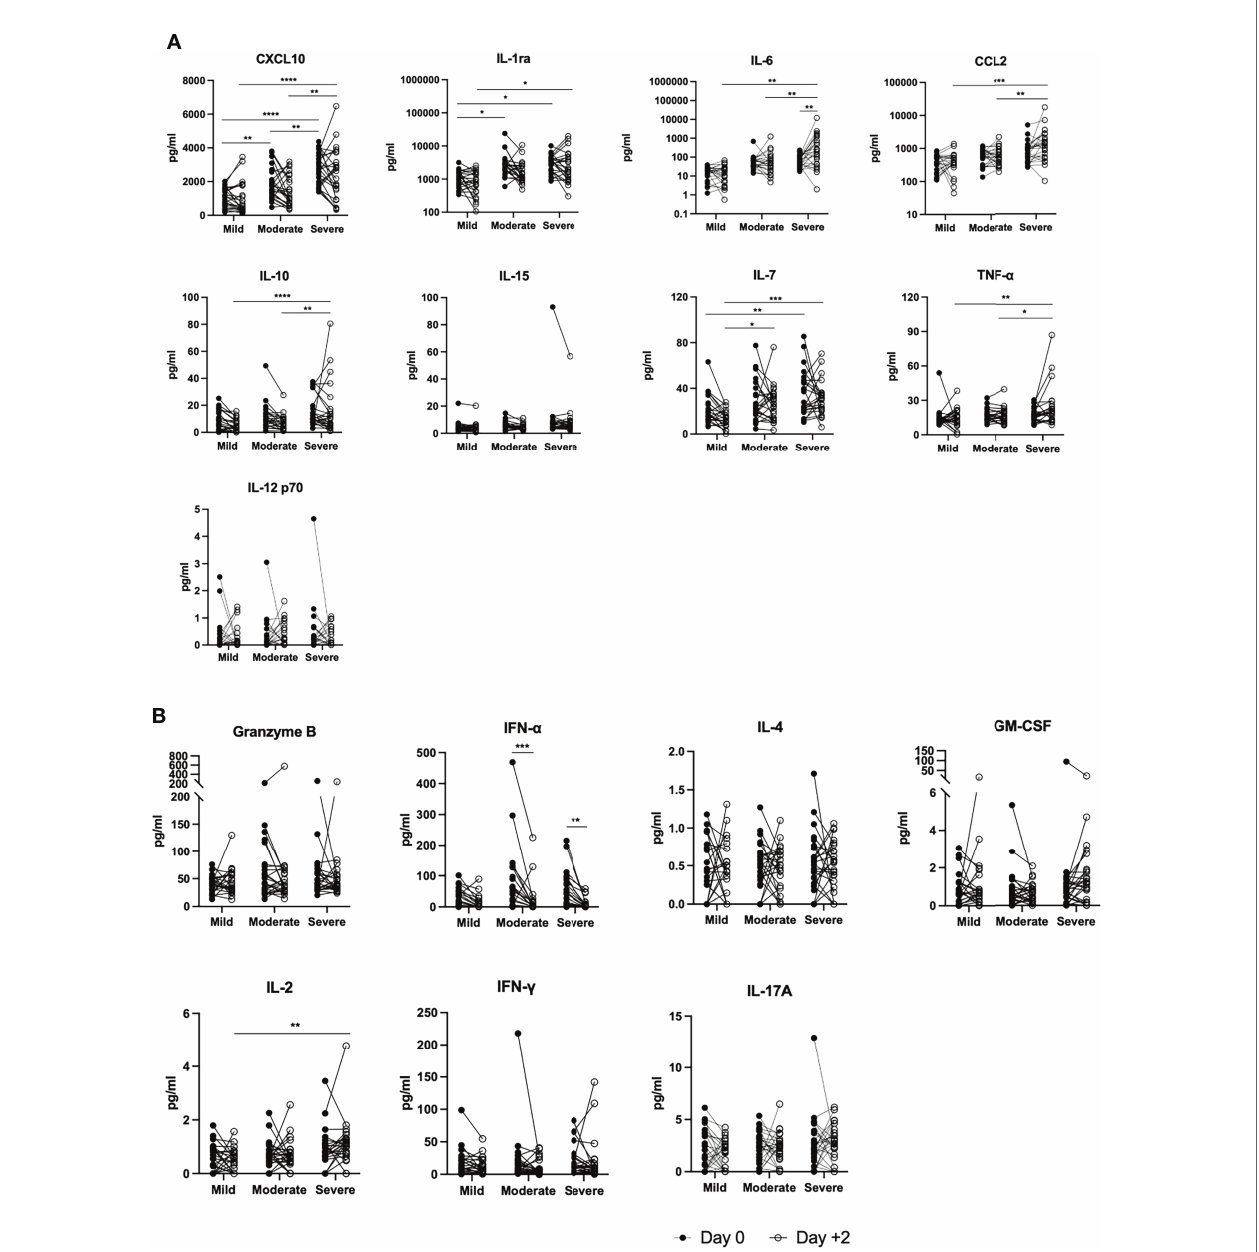
FIGURE 7 | Levels of cytokines and related factors in the Vall d ’ Hebron University Hospital cytokine studies sub-cohort. The levels of cytokines were measured in the ELLA ® platform cytokines on days 0 and +2, and the changes in the levels are shown as before/after graphs. (A) cytokines mediating innate immunity and (B) Granzyme N, IFN-alpha plus cytokines mediating mostly adaptive immunity. Outliers, de fi ned as values above mean + 2SD were identi fi ed for seven values. The three single con fi rmed outlier values for IL6, CXCL10 and CCL2 correspond to an early sample (day 3) of the same patient, a 44-years-old male born, in South America, without comorbidities, with severe COVID; despite the cytokine storm this patient survived and was discharged after over six weeks in hospital, four of them at the ICU with mechanical ventilation. He received two doses of TCZ as part of the treatment. Another three con fi rmed outlier values for IL-15, IL-12p70 and GM- CSF corresponded to early samples from a single patient, a 61-year-old female with severe pneumonia, chronic lung disease, hypertension, and obesity as risk factors; she survived and was discharged after 30 days in hospital most of them in the ICU with mechanical ventilation. A third patient, with had a single outlier value for IFN-alpha corresponded to a 61-year-old female, with diabetes and hypertension; she suffered moderate COVID, remained at the regular hospital ward and was discharged after two weeks; patients was doing well at censoring time *p < 0.05; **p < 0.01; ***p < 0.001; ****p <